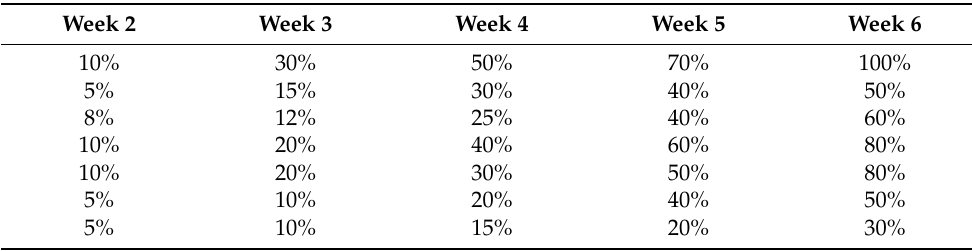
Table 7. Percentages of adherence to focus of attention from week 2 to week 6 of the intervention phase for the seven